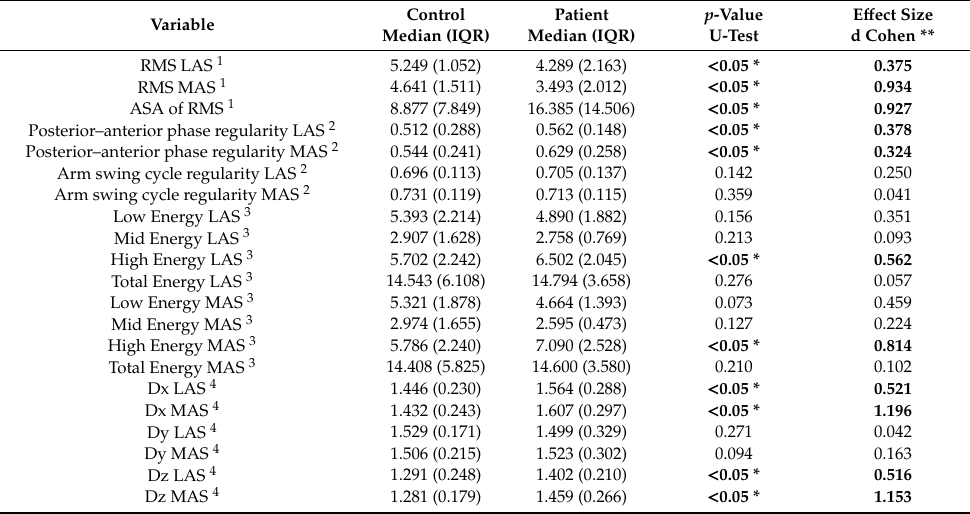
1 Variable extracted by the root mean square (RMS) and RMS asymmetry calculation. 2 Variable extracted by regularity estimation. 3 Variable extracted by arm swing energy distribution. 4 Variable extracted by wavelet decomposition applied to x, y and z axis of wrist accelerometer signal. * The variable has a normal distribution. ** The variable presents significant di ff erences between patients and controls. ASA = asymmetry in the arm swing, LAS = least a ff ected side, MAS = most a ff ected